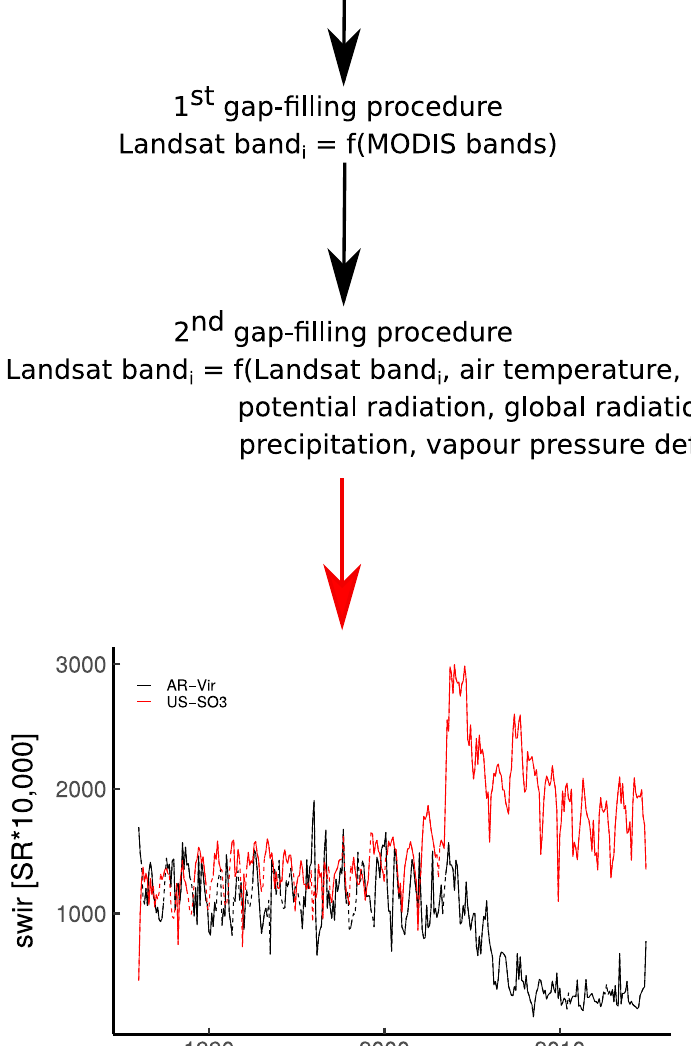
PLOS ONE | https://doi.org/10.1371/journal.pone.0211510 February 6, 2019 5 /